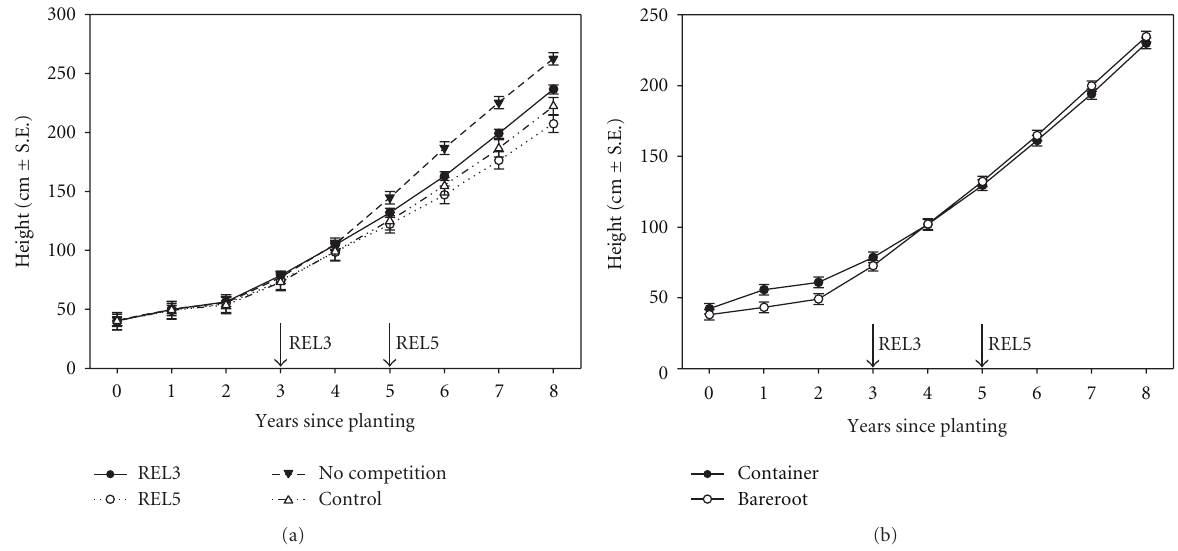
Figure 5: Profile of height over eight growing seasons of large Picea glauca seedlings outplanted in south central Quebec (Canada). (a) Presents height for each of four vegetation management treatments that were compared. Treatments consisted of four intensities of vegetation management, including a control, mechanical release during the third growing season (REL3), mechanical release during the fifth growing season (REL5), and plots where competition for light was eliminated through repeated herbicide and mechanical release treatments (No competition: NC). (b) Presents height by stock type.